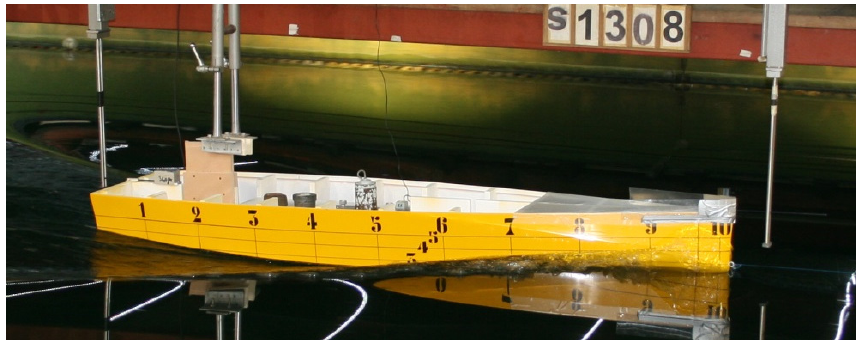
Figure 5. Scale model at Fr = 0.5 tested in the Naples’ towing tank.